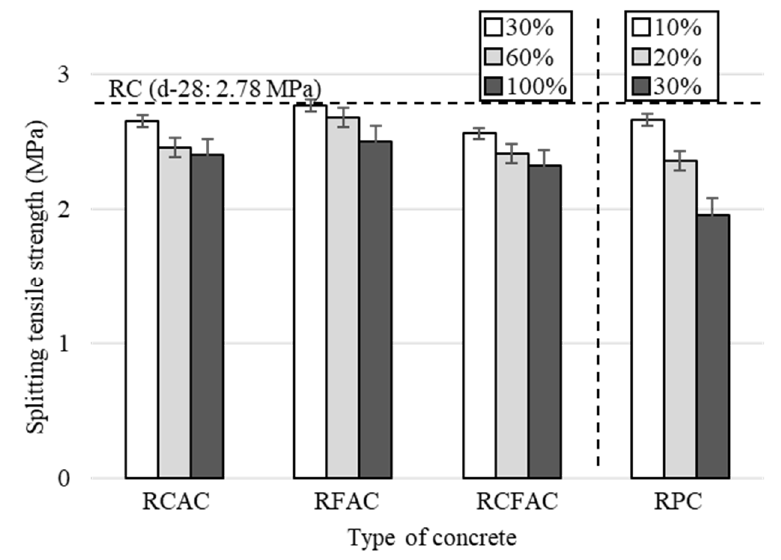
Figure 6. Test results of splitting tensile strength of concretes made of recycled aggregates and re- cycled powder.